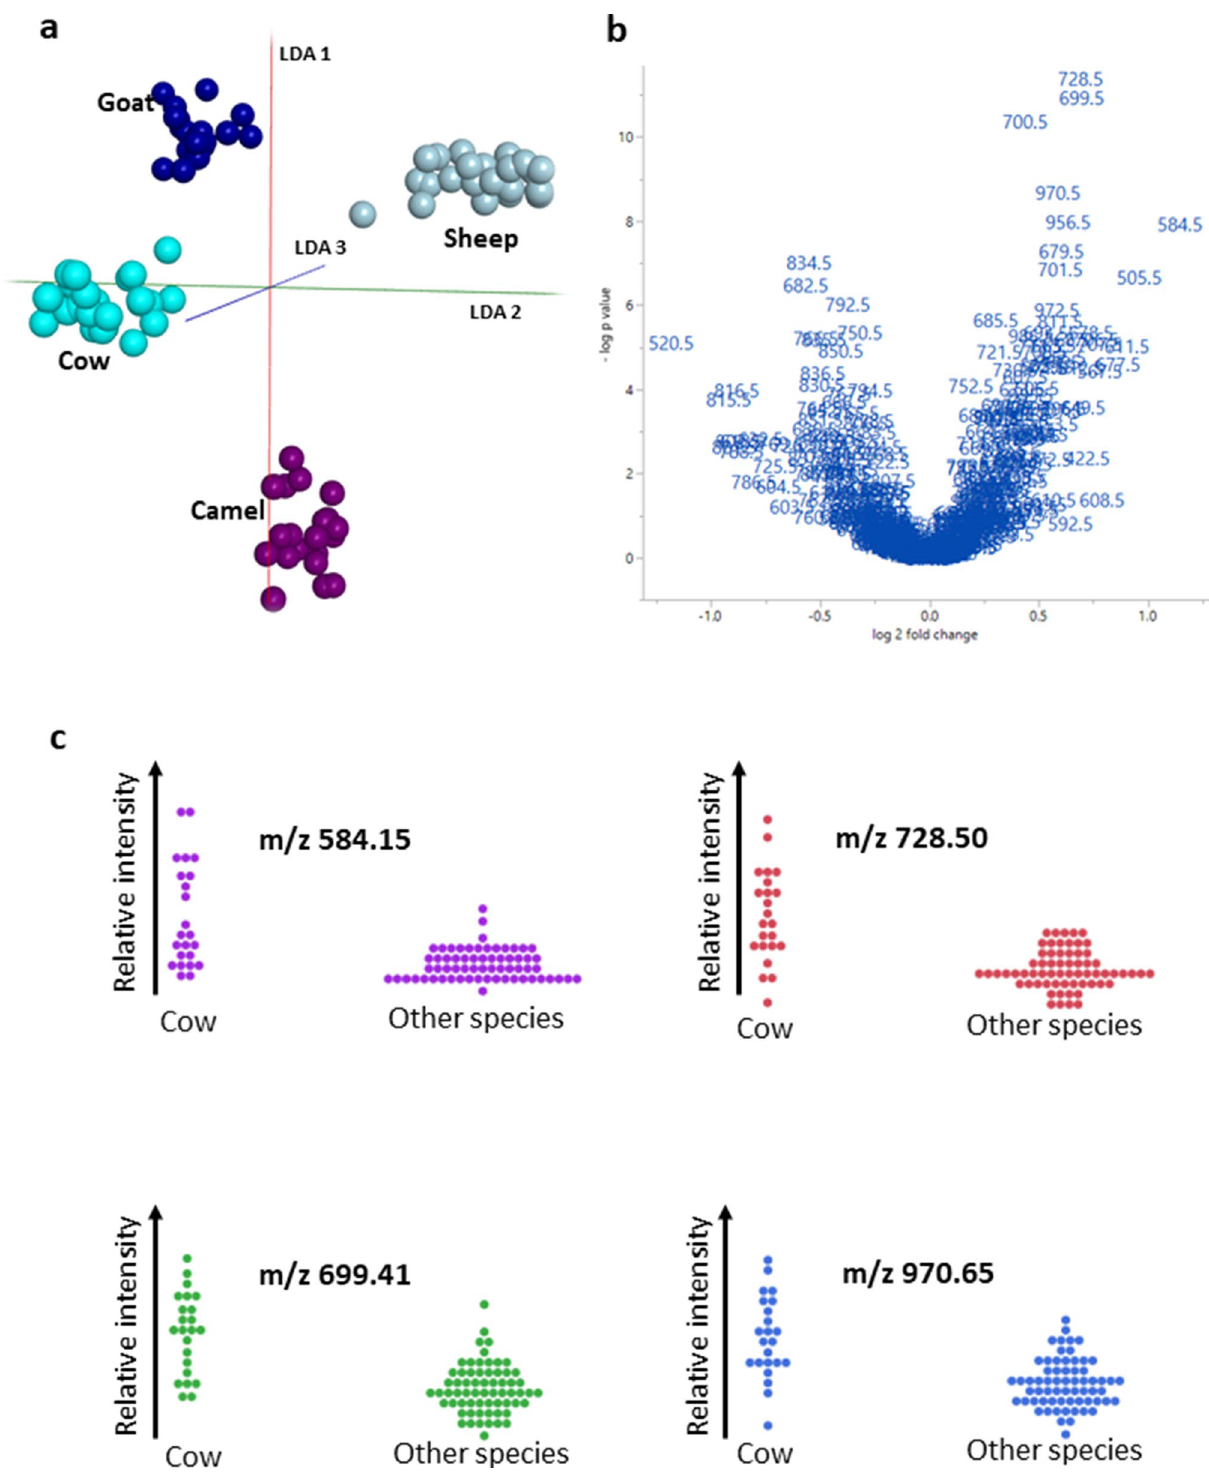
Figure 1. ( a ) Linear Discriminant Analysis (LDA) plot obtained with Abstract Model Builder (AMX) from the MS profile data of sample sets of four different mammals, using the m/z range from 400 to 1000. ( b ) Volcano plot displaying the m/z values of ions linked to cow milk classification. ( c ) Graphical representation of some of the most significant differences in the relative signal intensities for lipid ions that are highly relevant for cow milk classification. Based on their m/z values the peaks at m/z 699.41 and m/z 728.50 can be putatively assigned to the [M + H] + ion species of glycerophosphoinositol PI 24:0 and glycerophosphoethanolamine PE 35:3 or glycerophosphocholine PC 32:3 ,